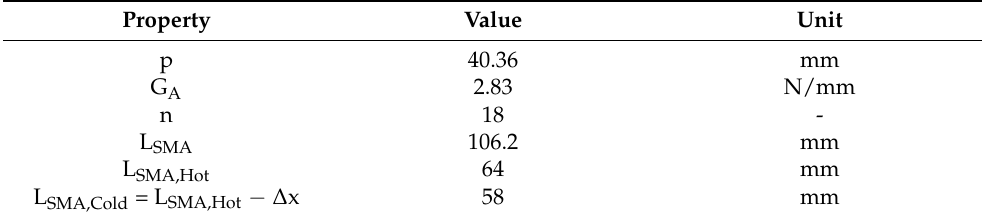
Table 5. Simulated results for the SMA spring.